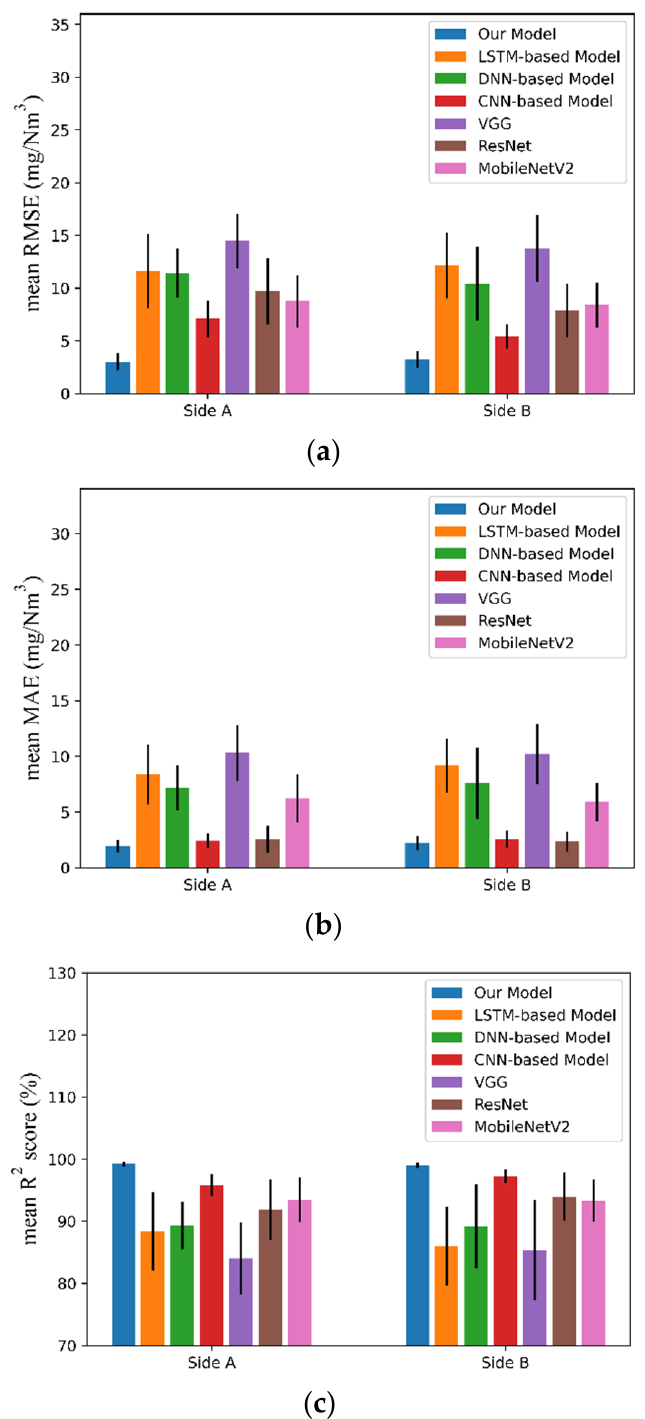
Figure 5. Prediction performance of the seven NOx prediction models on the test subset for 30 runs. ( a ) The mean of RMSE values with the standard deviation of RMSE values. ( b ) The mean of MAE values with the standard deviation of RMSE values. ( c ) The mean of R 2 scores with the standard deviation of R 2 scores.